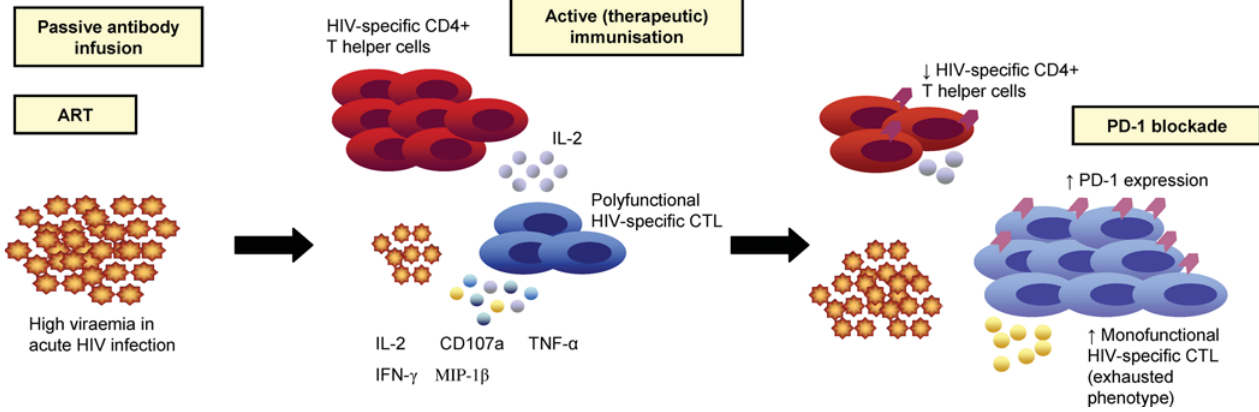
Figure 1. Sequence of Events from Acute to Chronic HIV Infection and Potential Interventions to Combat T Cell Exhaustion IFN, interferon; MIP, macrophage infl ammatory protein; TNF, tumour necrosis